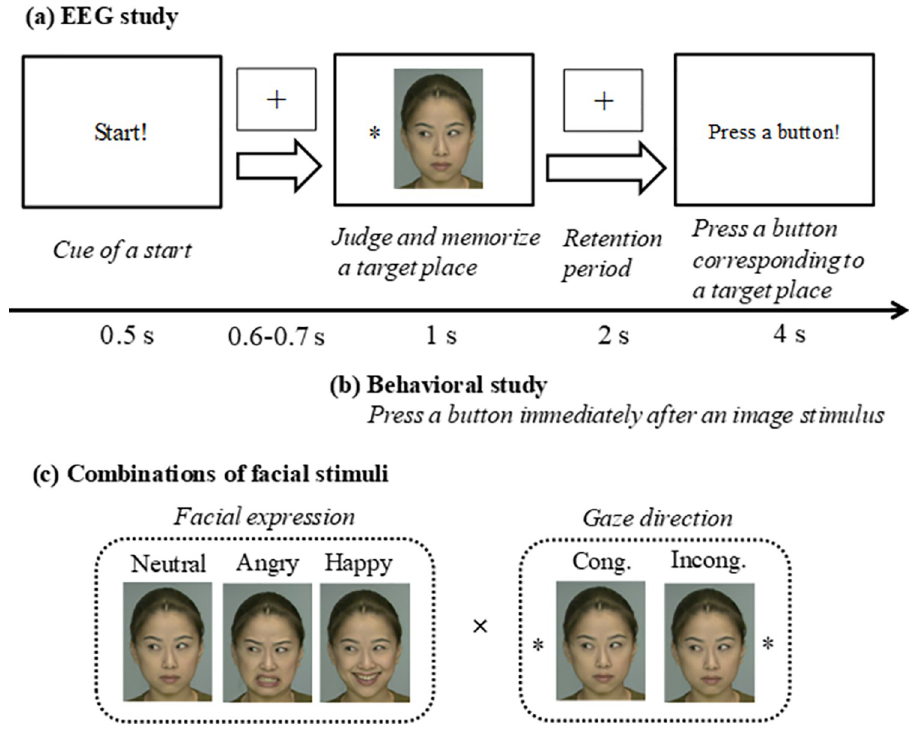
Fig 1. Experimental procedures for (a) EEG and (b) behavioral studies. One of the (c) multiple facial images was presented at each trial: a neutral, angry, and happy face with either a congruent (50%) or incongruent (50%) gaze direction toward a target (left or right). Reprinted from the ATR Facial Expression Image Database DB99 under a CC BY license, with permission from ATR-Promotions Inc., original copyright (2006). 2.1.4 Experimental procedures. The sensors for EEG recording were attached to the par- ticipants. The participants were asked to practice the experiment (at least 10 trials for children and 5 trials for adults) during an acclimation period. We then performed the EEG experiment to evaluate attention-shifting abilities during the working memory task. Fig 1 shows the experi- mental procedure for a single trial of EEG recording. A ‘Start!’ stimulus of 500 ms was followed by a jittering period (the presentation of ‘+’ as a fixation cross) between 600 and 700 ms. A face [i.e., neutral, angry, or happy face with a left or right gaze congruent (50%) or incongruent (50%) with the target direction] was randomly presented onscreen for 1 s, followed by a mem- ory retention period of 2 s (‘+’ as a fixation cross). The participants were then asked to press a left or right button using the thumbs of both hands, corresponding to the laterally presented target (‘ � ’) direction. The time limit to answer was set to 4 s. An attention getter was used to inform the participant to start the next trial (a resting interval of 4 s). One block consisted of 24 trials (4 trials under each stimulus condition). The next block was started after the partici- pants finished a rest period of a few minutes. In total, each participant performed five blocks. The number of trials and blocks was based on preliminary experiments and data analyses, con- sidering the relatively slow EEG waves such as θ and α bands. At the end of the experiment, the experimenter verbally asked the children to judge the emotional expressions of the ran- domly presented faces used for this experiment. The experimenter told the children whether the face in the picture was smiling, angry, or neither (i.e., neutral). The children answered ‘yes’ or ‘no’, and the experimenter manually recorded their responses.